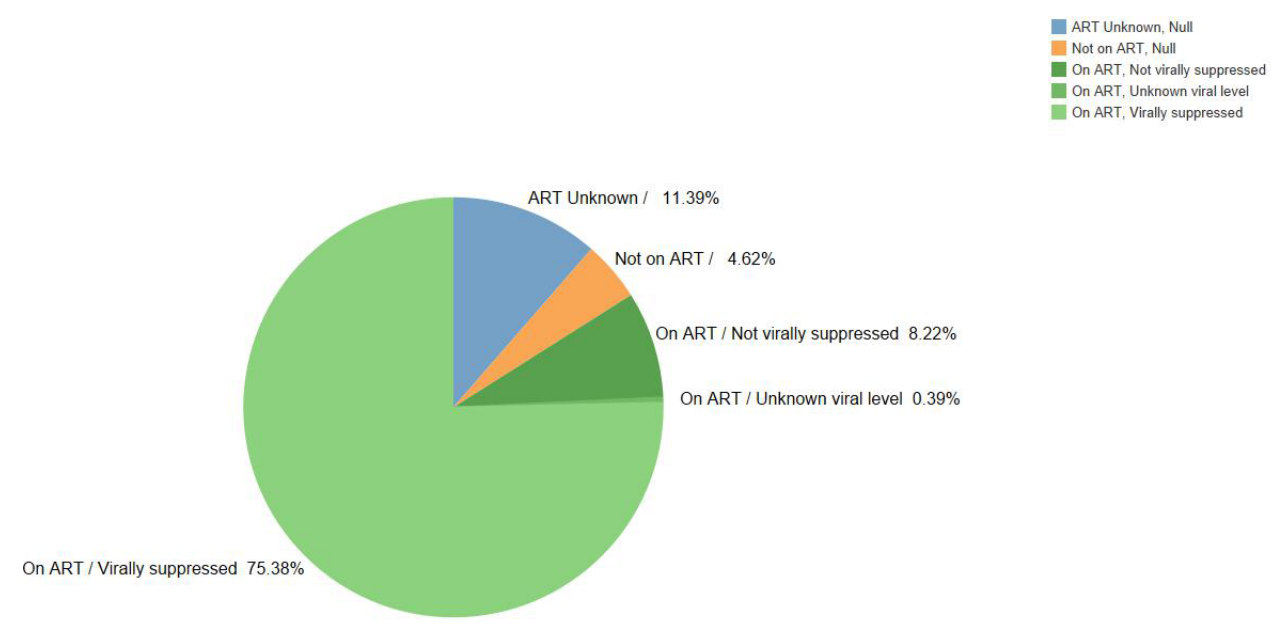
Figure 4. ART status within each couple at the end of the study follow-up.